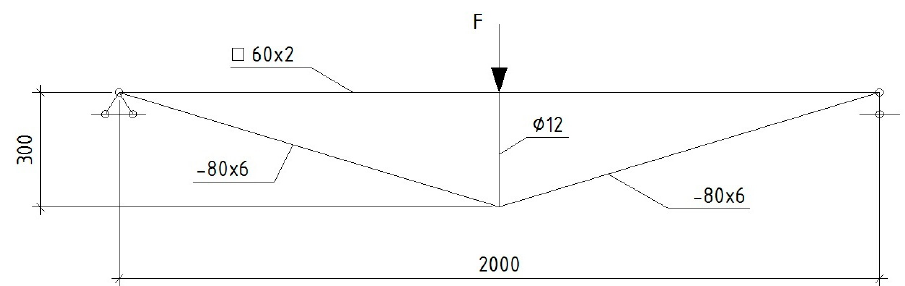
Figure 3. Geometric scheme of truss No. 1 (loss of stability and destruction of the upper chord).